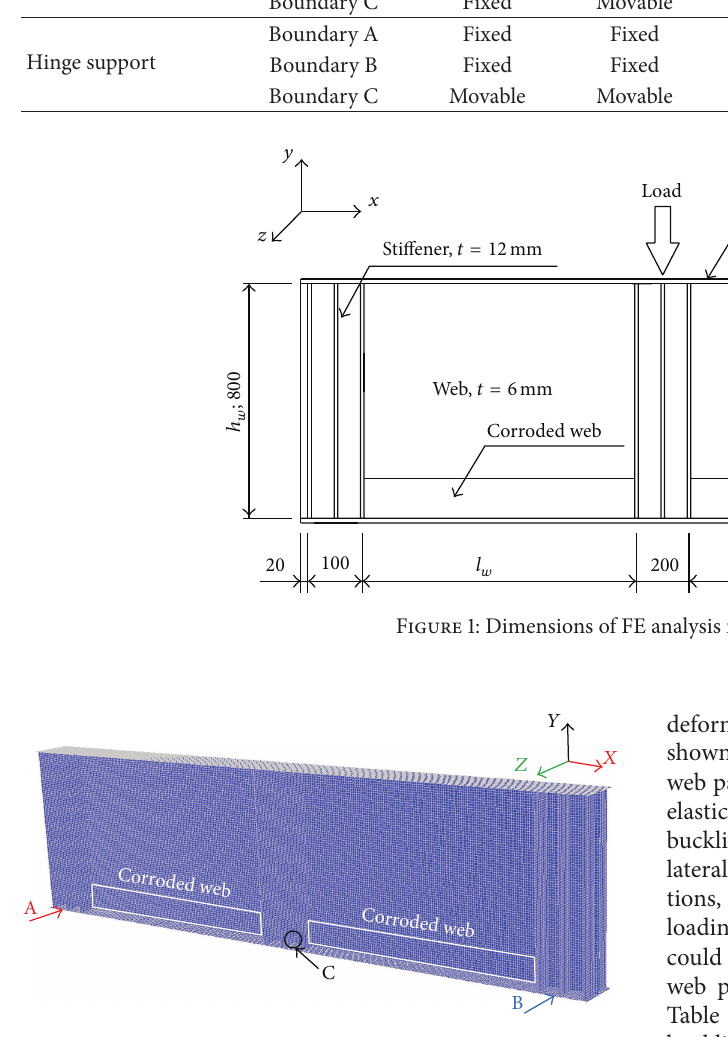
Figure 2: FE analysis